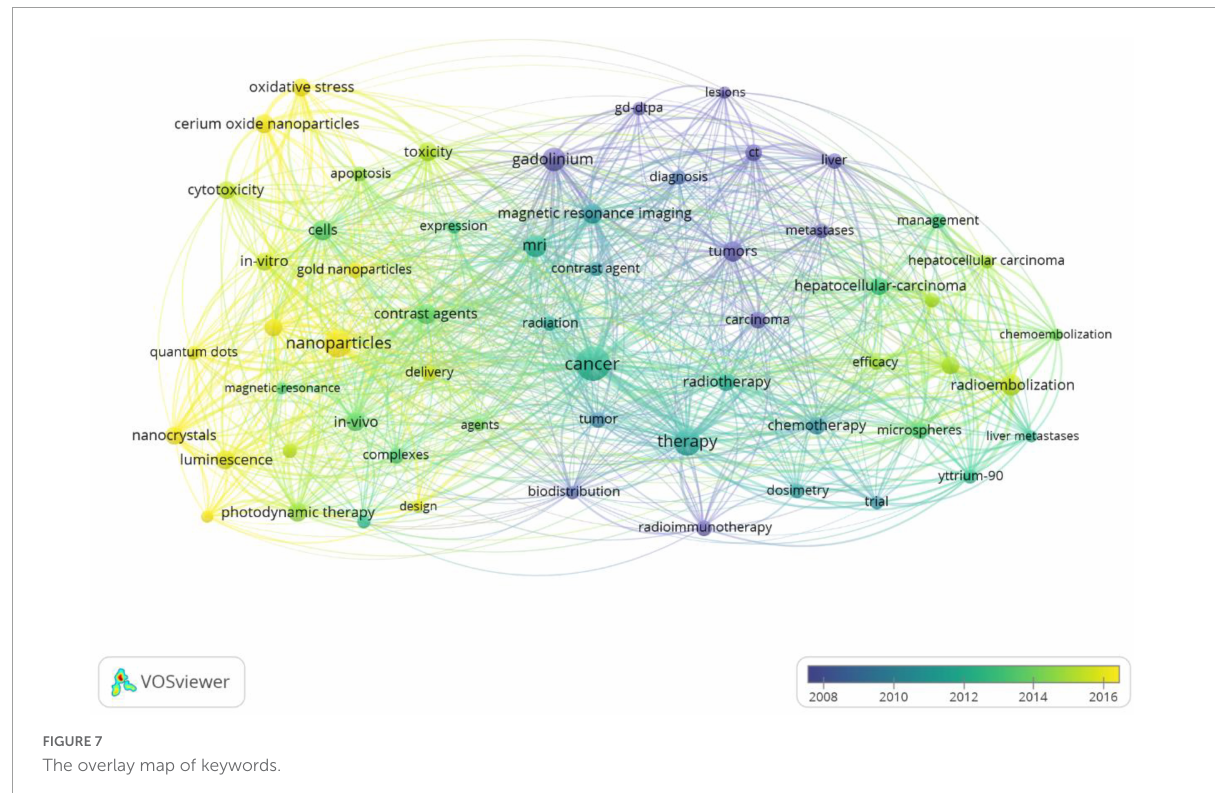
FIGURE7 The overlay map of keywords.